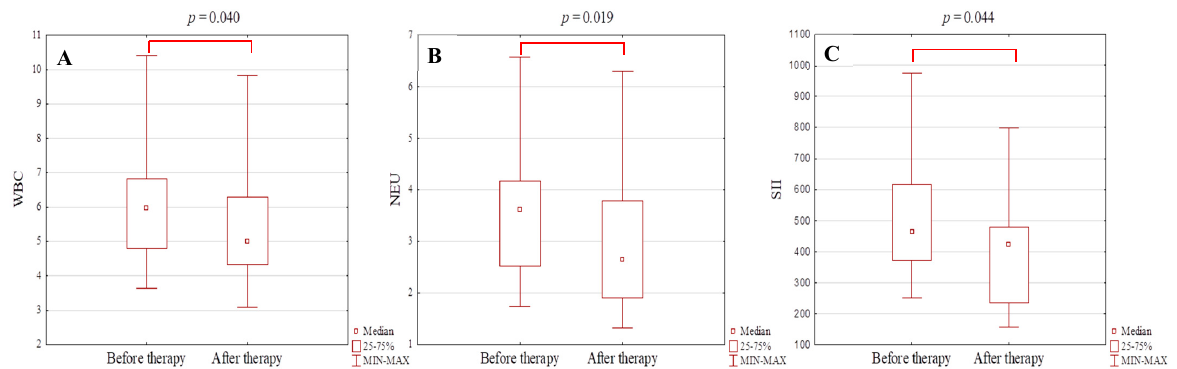
Figure 2. ( A – C ) Differences in hematological parameters and derived ratios in patients with acromegaly during pretreatment period and after SSA therapy ( n = 20). The Wilcoxon rank-sum test was used in the analysis. p -value < 0.05 was statistically